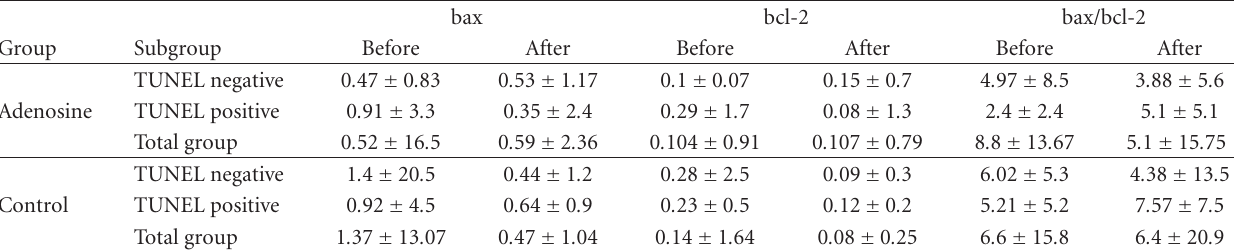
Table 2: TUNEL positive and negative subgroups (of the ventricular samples) in both the adenosine and control groups in correlation with the changes of apoptosis-regulating genes in the atria samples. bax bcl-2 bax/bcl-2 Group Subgroup Before After Before After Before After TUNEL negative 0 . 47 ± 0 . 83 0 . 53 ± 1 . 17 0 . 1 ± 0 . 07 0 . 15 ± 0 . 7 4 . 97 ± 8 . 5 3 . 88 ± 5 . 6 Adenosine TUNEL positive 0 . 91 ± 3 . 3 0 . 35 ± 2 . 4 0 . 29 ± 1 . 7 0 . 08 ± 1 . 3 2 . 4 ± 2 . 4 5 . 1 ± 5 . 1 Total group 0 . 52 ± 16 . 5 0 . 59 ± 2 . 36 0 . 104 ± 0 . 91 0 . 107 ± 0 . 79 TUNEL negative 1 . 4 ± 20 . 5 0 . 44 ± 1 . 2 0 . 28 ± 2 . 5 4 . 38 ± 13 . 5 Control TUNEL positive 0 . 92 ± 4 . 5 0 . 64 ± 0 . 9 0 . 23 ± 0 . 5 0 . 12 ± 0 . 2 5 . 21 ± 5 . 2 7 . 57 ± 7 . 5 Total group 1 . 37 ± 13 . 07 0 . 47 ± 1 . 04 0 . 14 ± 1 . 64 0 . 08 ± 0 . 25 6 . 6 ± 15 . 8 6 . 4 ± 20 .